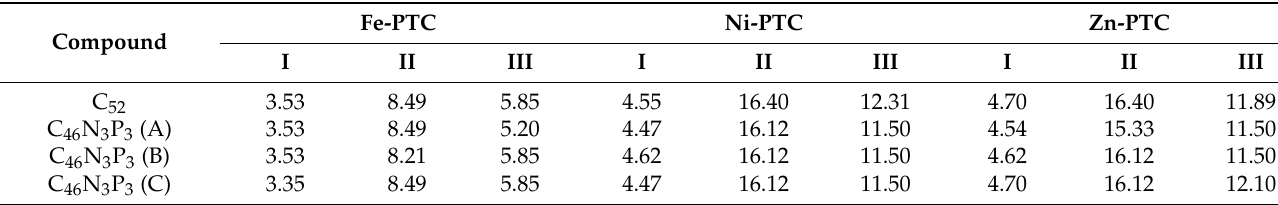
Table 18. Calculated constant binding K B ( · 10 4